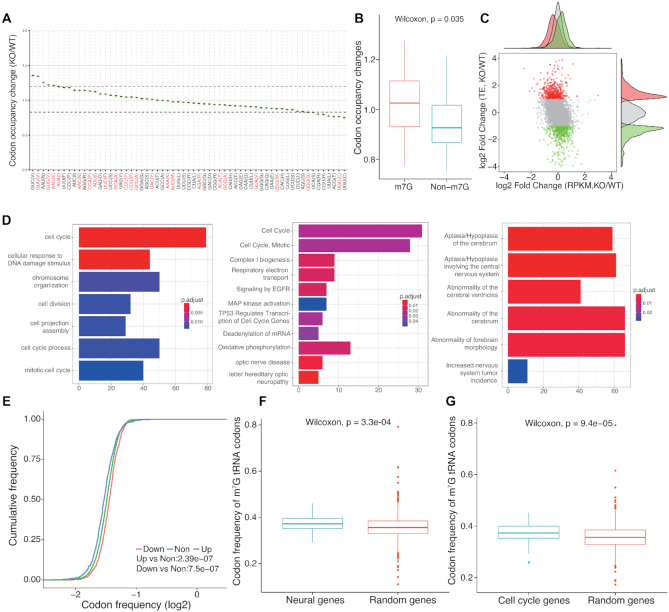
RiboToolkit analysis reveals significant changes in codon occupancy and mRNA translation in Mettl1 knockout. (A) Codon occupancy changes between Mettl1 knockout and wild type. (B) The boxplot of codon occupancy changes comparing codons decoded by m7G tRNAs and other codons. (C) The scatter plot of translation efficiency changes versus gene expression changes. The red and green dots represent translationally up-regulated and down-regulated genes (≥2-fold changes), respectively. Many genes showed differential translation in Mettl1 knockout mESCs while the global mRNA expression changes are limited compared with the changes in mRNA translation. (D) Functional enrichments of differentially translated genes. (E) Cumulative distribution of codon frequencies among up-regulated, down-regulated, and non-differentially translated mRNAs. (F) Codon frequency of m7G tRNA decoded codons in neural genes. (G) Codon frequency of m7G tRNA decoded codons in cell cycle genes.